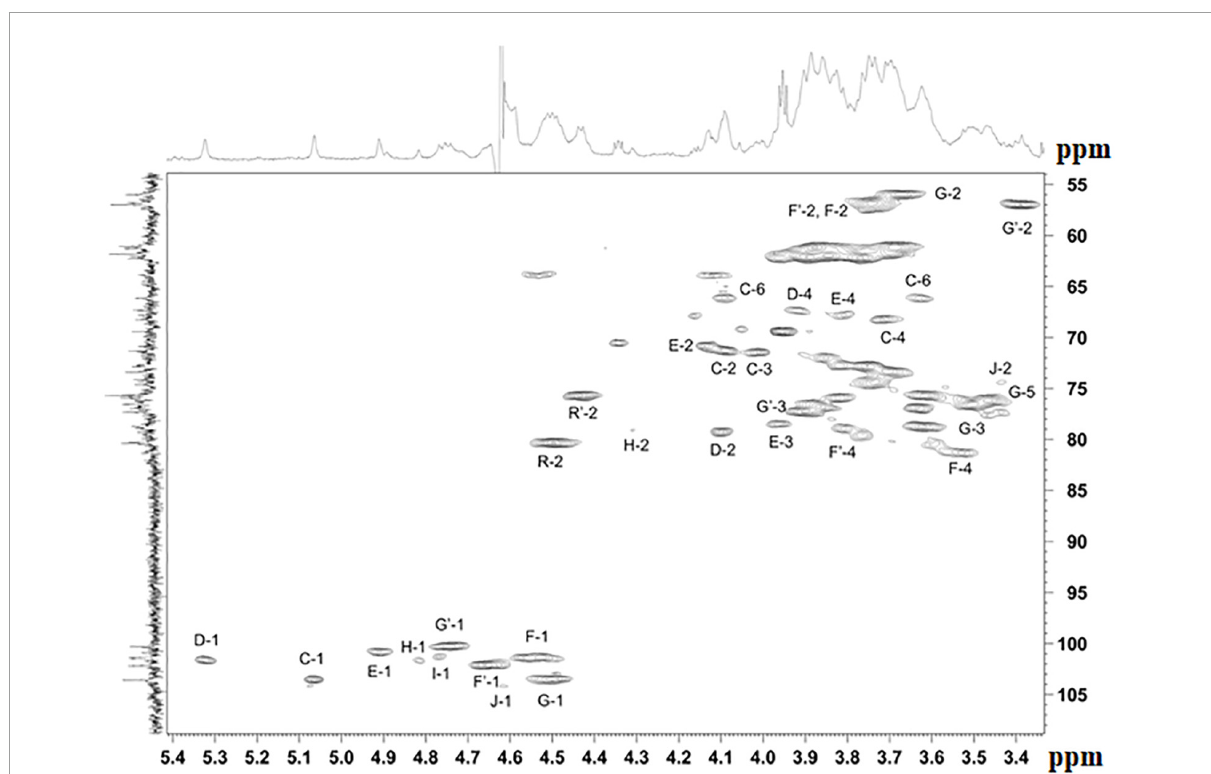
FIGURE4 Parts of the 2D 1 H, 13 C edHSQC spectrum of M. luteus C01 matrix polysaccharides [24 h (control)] eluted in 0.1 M phosphate buffer. The corresponding parts of the 1 H and 13 C NMR spectra are shown along the horizontal and vertical axes, respectively. Numbers refer to protons and carbons of sugar units designated by the letters shown in Table 5